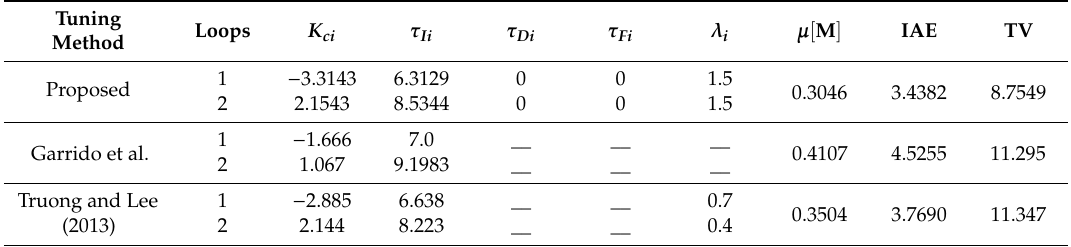
Table 7. Controller parameters and resulting performance indices for the VL column.